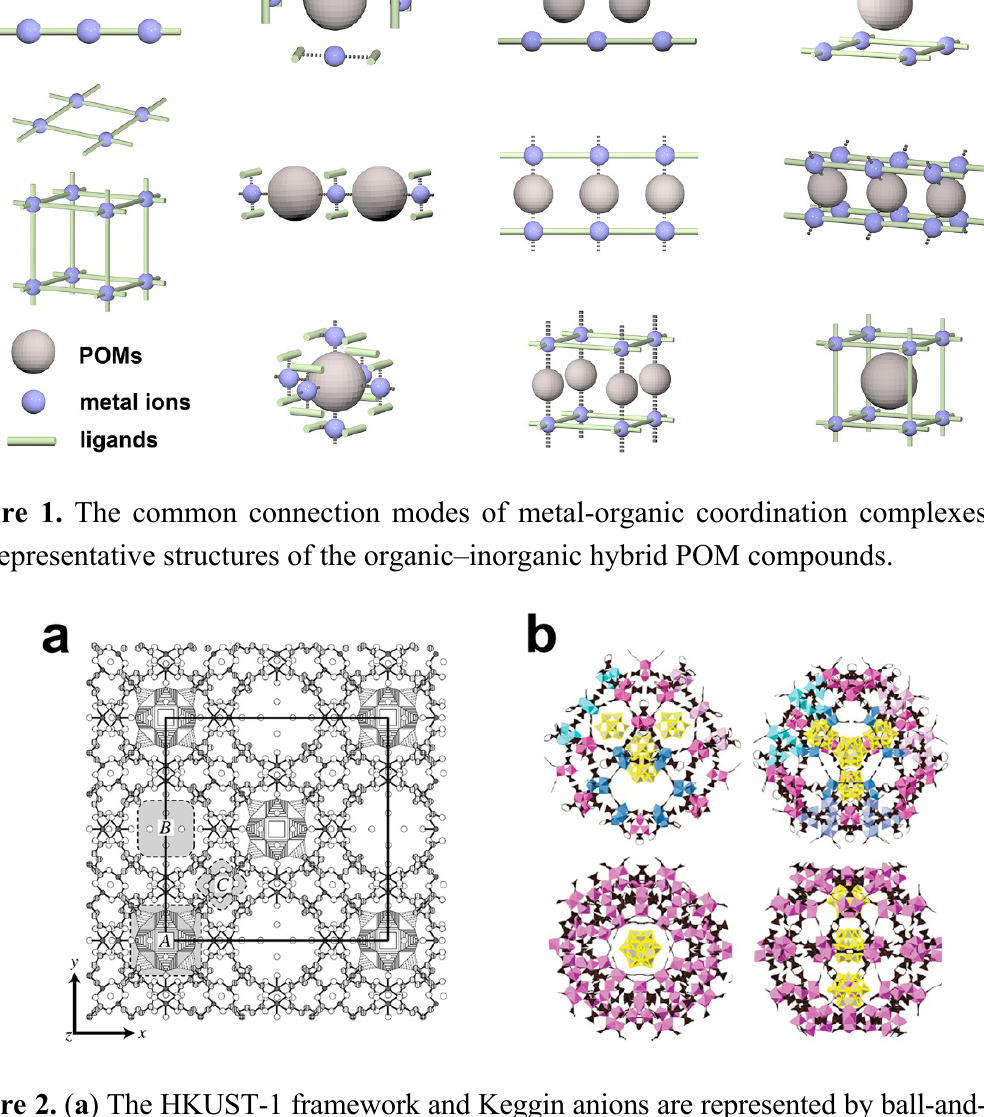
Figure 2. ( a ) The HKUST-1 framework and Keggin anions are represented by ball-and-stick and polyhedral models, respectively. Reproduced with permission from Elsevier, 2003 [31]; ( b ) Proposed crystal structure of MIL-101/PTA. Reproduced with permission from America Chemical Society (ACS), 2012